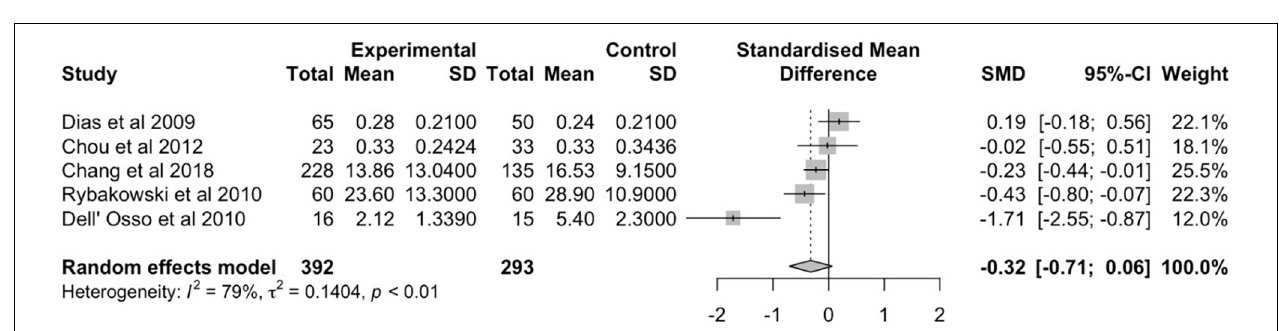
FIGURE 3 | Forest plot of standardized mean difference (SMD) in BDNF levels found in blood of patients with bipolar disorder and healthy